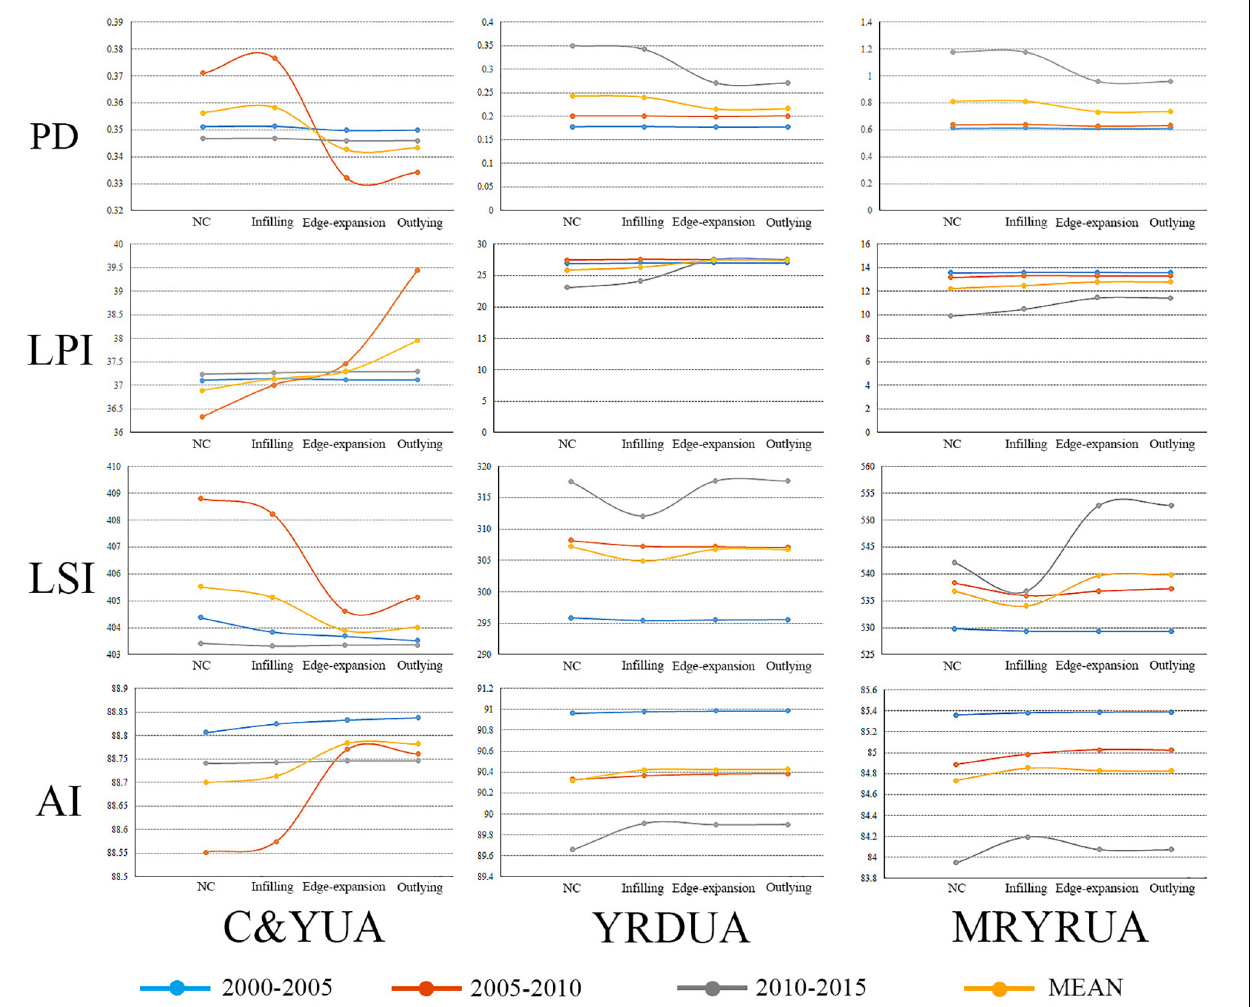
FIGURE 7 | Cropland metrics change in YRDUA, MRYRUA, and C&YUA from 2000 to 2015. NC represents the no changed cropland during the research period. Infilling includes the no change and infilling cropland. Edge-expansion consists of the cropland with no change, infilling, and edge-expansion. Outlying represents the cropland with no change, infilling, edge-expansion, and